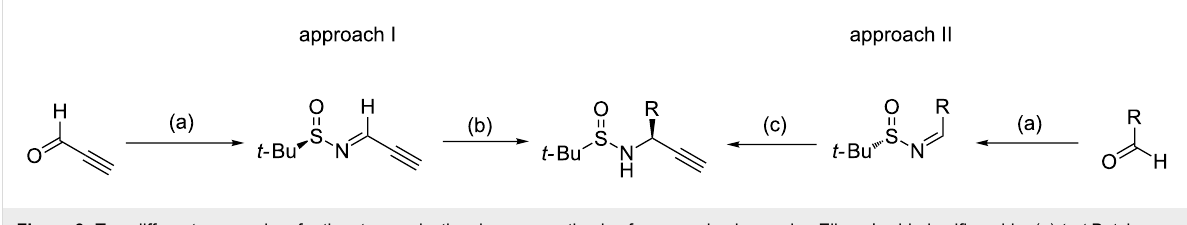
Figure 3: Two different approaches for the stereoselective de novo synthesis of propargylamines using Ellman’s chiral sulfinamide. (a) tert -Butyl sulfinamide, Lewis acid, CH 2 Cl 2 . (b) Organometallic compound. (c) (Trimethylsilyl)ethynyllithium.